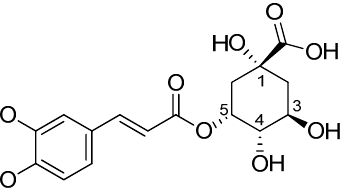
Figure 1. Chemical structure of chlorogenic acid (CGA).